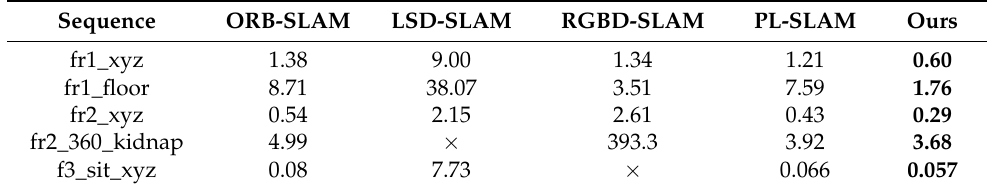
Table 3. Comparison of RMSE (cm) of five algorithms on TUM dataset.